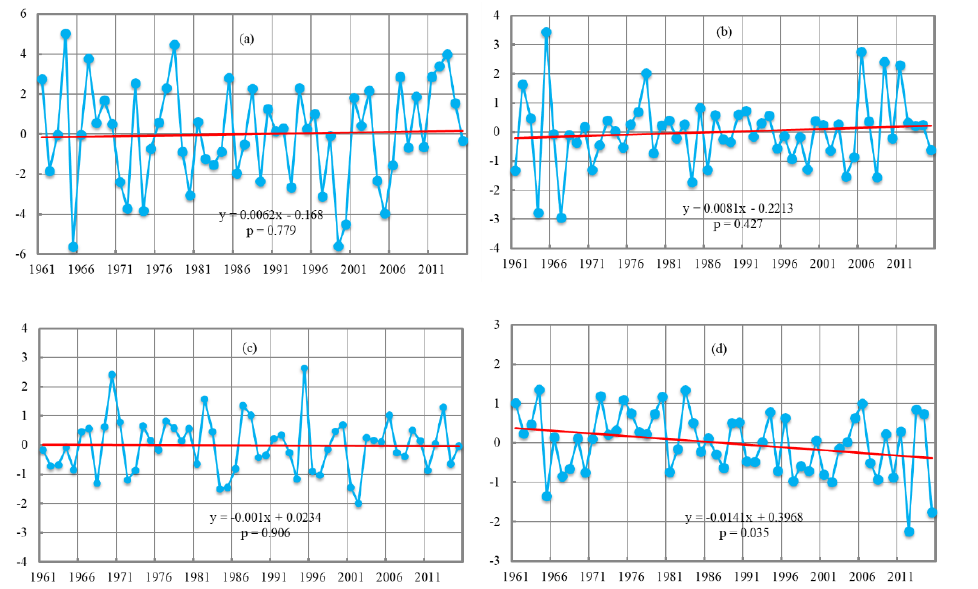
Figure 4. The first four eigenvectors of the Empirical Orthogonal Function (EOF) of the summer SPI from 1961 to 2015 in Yulin City of the northern Shaanxi. ( a ) EOF1, ( b )EOF2, ( c )EOF3, ( d )EOF4.